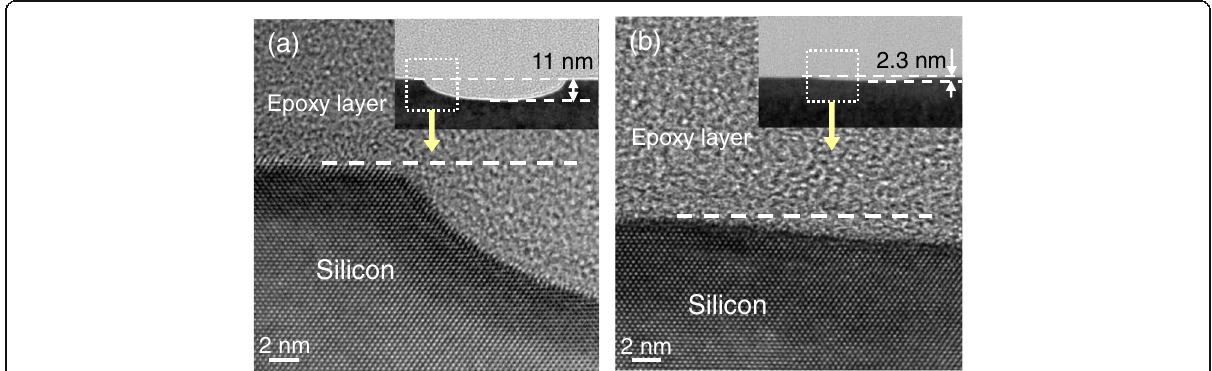
Fig. 3 High-resolution TEM images of wear scar on Si substrate formed at sliding speed values of 0.08 ( a ) and 50 μ m/s ( b ) in humid air. The insets show the wear scars with depths of ~11 nm in ( a ) and 2.3 nm in ( b